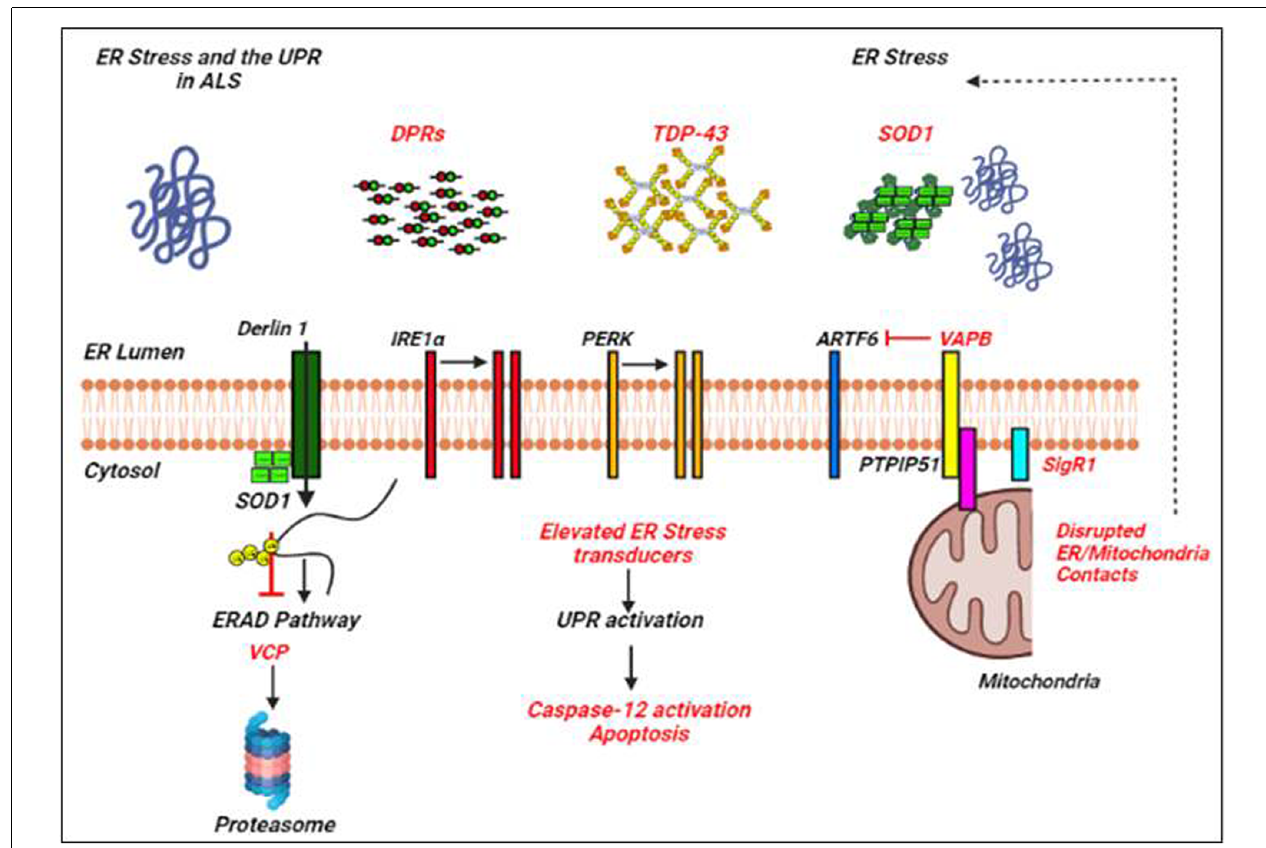
FIGURE 2 | ER stress and the UPR in amyotrophic lateral sclerosis (ALS). Examples of ALS-linked genes involved in ER stress and the UPR are shown in red text. ALS-associated defects to the UPR are also mentioned in red text. Adapted from Webster et al.